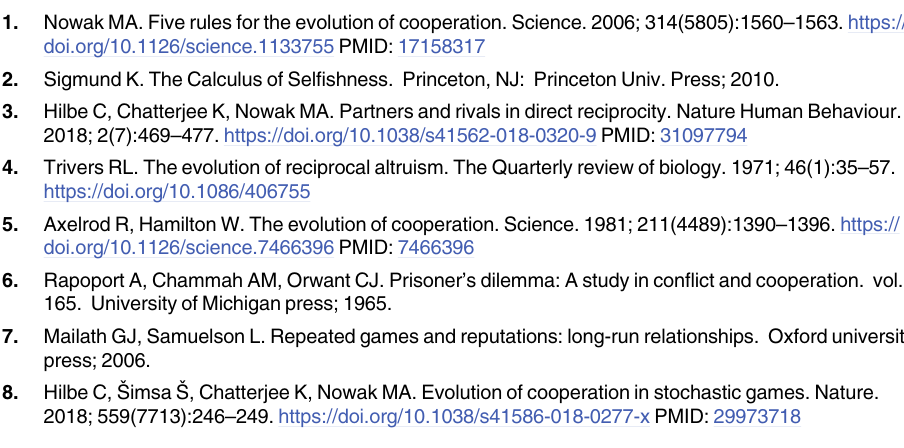
Simulations are run for T = 10 9 time steps. Table T. Self scores and combined scores for Extension 4 under β = 10. The table shows the same type of data as Table 3, but for the model extension where high memory players imitate their co-player’s strategy with probability α = 0.05, whereas with the same probability low-memory players infer their co-player’s effective memory strategy. Memory-1 strategies still have the largest self payoff. However, reactive strat- egies have the largest combined score for c < 0.9. Simulations are run for T = 10 9 time steps. Table U. Self scores and combined scores for Extension 5 under β = 10. The table shows the same type of data as Table 3, but for the model extension where players are allowed to search for a new strategy until the mutant is accepted. Memory-1 strategies still have the largest self payoff except for c = 0.1. However, unconditional strategies have the largest combined score for all values of c . Simulations are run for T = 10 9 time